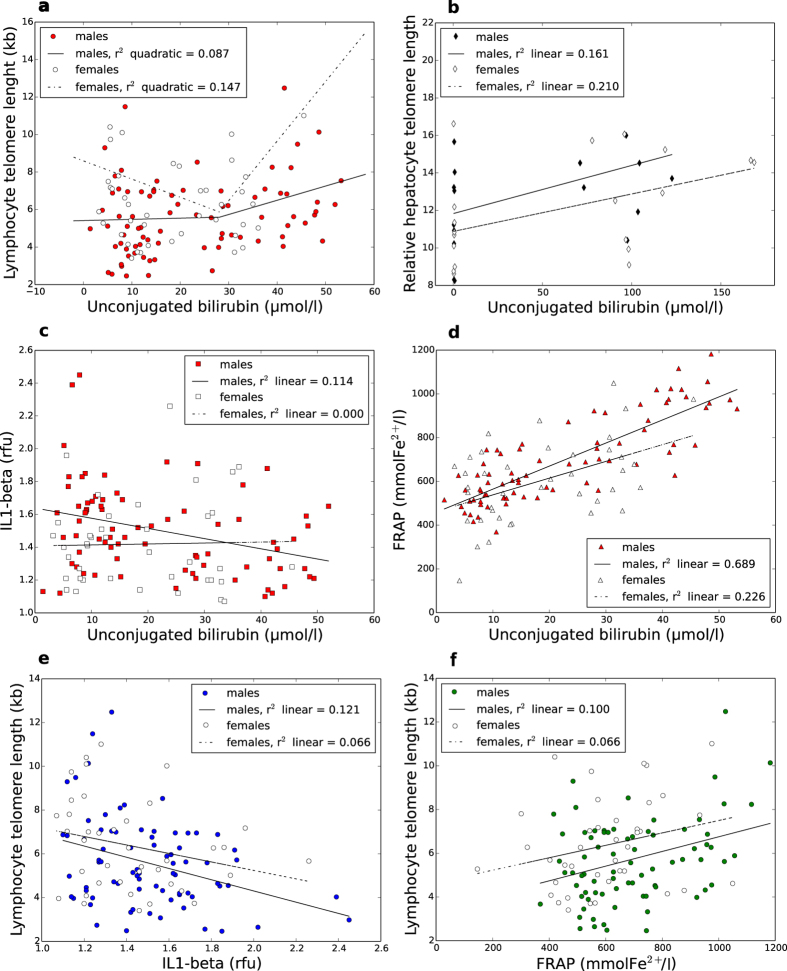
Correlation of serum UCB with telomere length, serum antioxidant capacity and intracellular interleukins in humans; plasma UCB and hepatocyte telomere length in rats.(a) Association between UCB and telomere length in males and females; quadratic model: P(males) = 0.03, P(females) = 0.053; linear model: P(males) = 0.012, P(females) = 0.713. (b) Plasma UCB and relative hepatocyte telomere length in rats; P(males) = 0.110, P(females) = 0.048. (c) UCB and IL1β; P(males) = 0.003, P(females) = 0.879. (d) UCB and FRAP; P(males) < 0.001, P(females) = 0.002. (e) IL1β and lymphocyte telomere length; P(males) = 0.002, P(females) = 0.110. (f) FRAP and lymphocyte telomere length; P(males) = 0.005, P(females) = 0.111.